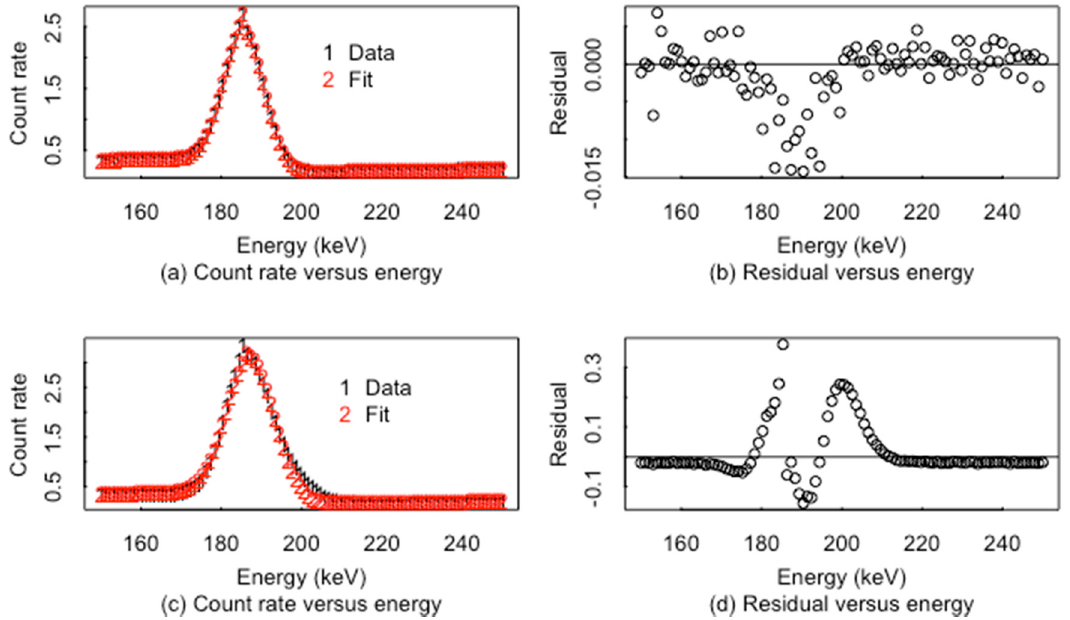
Figure 5. ( a , b ) fit one peak to one peak, and ( c , d ) fit one peak to two close peaks.